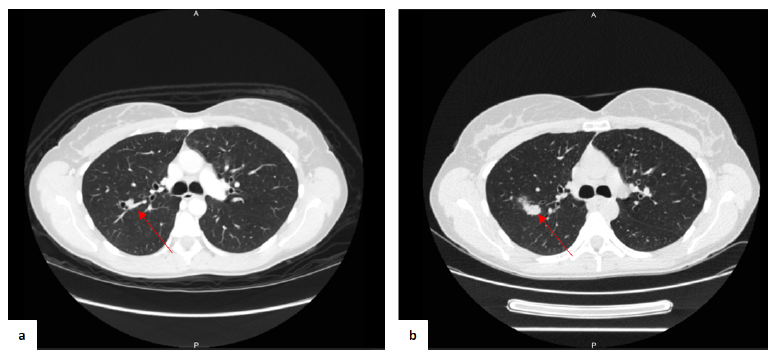
Figure 1. CT scan images of the first findings ( a ) and the findings after eight-month follow-up associated with antibiotic therapy ( b ). The nodule is indicated by the red arrow.